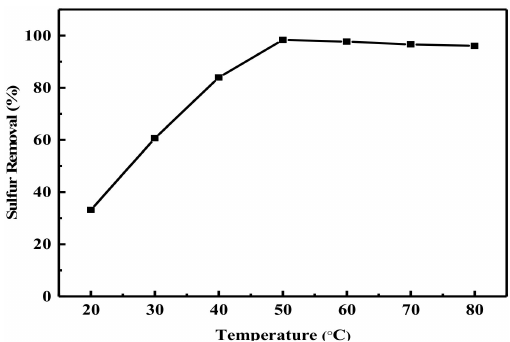
Figure 4. Effect of reaction temperature on desulfurization. Reaction conditions: V(oil) = 5 mL; n(catalyst)/n(S) = 0.025; n(H 2 O 2 )/n(S) = 6; V(acetonitrile) = 0.5 mL; t = 60